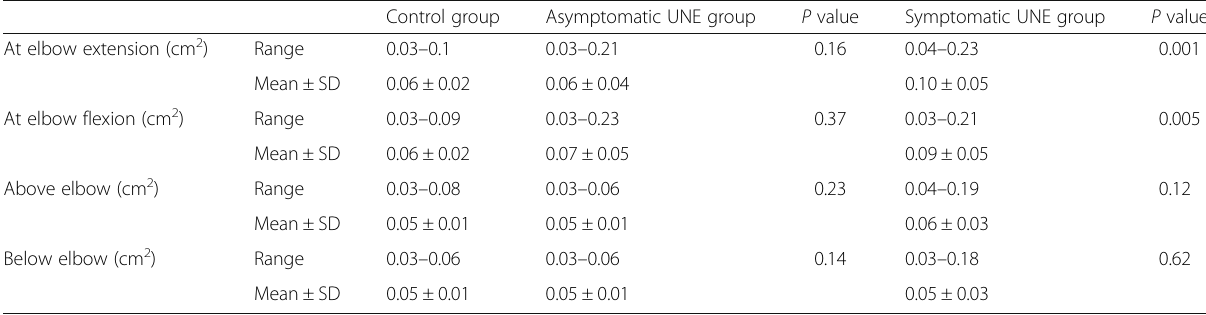
Table 1 Cross-sectional area (CSA) of the ulnar nerve in the asymptomatic ulnar nerve entrapment (UNE) group and the symptomatic UNE group compared to the control group